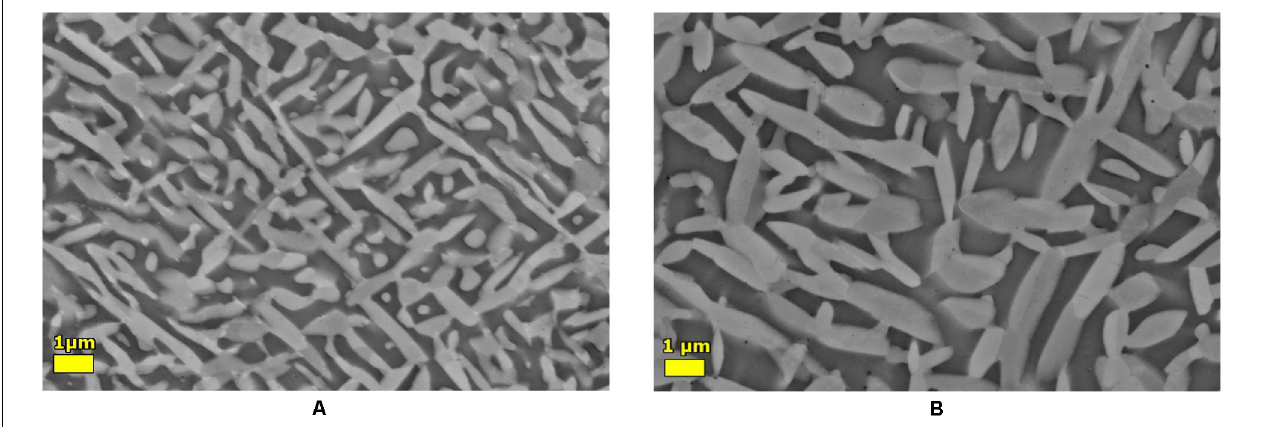
FIGURE 7 | SEM micrographs of the AlCrFe 2 Ni 2 microstructures after heat treatment at 900 ◦ C-6 h (A) and 950 ◦ C-6 h (B) , respectively.